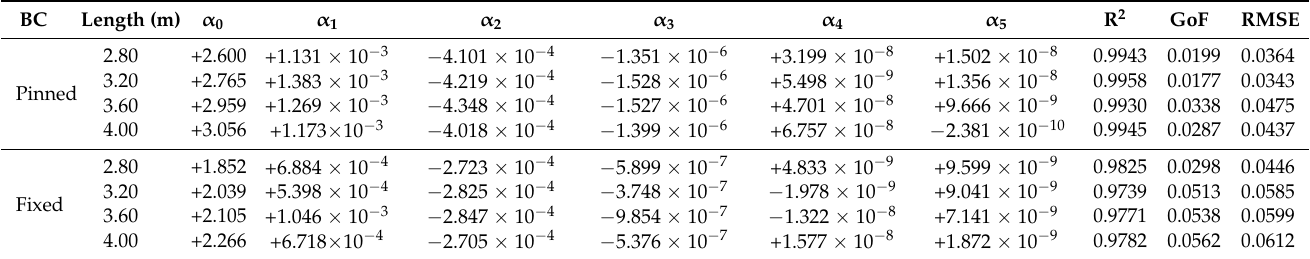
Figure 8. DI histograms, as obtained from MCS for IPB260 steel column with length of 3.6 m and pinned ends under: ( a ) 55, ( b ) 275 and ( c ) 555 kg of TNT. Table 3. ConstantcoefficientsofEquation(11)andcorrespondingR 2 ,